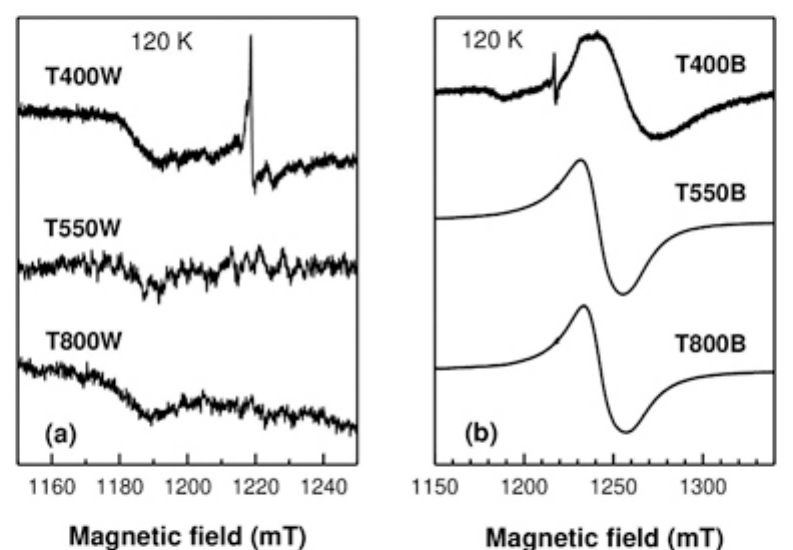
Figure 5. Q-band EPR spectra of the white ( a ) and black ( b ) samples at 120 K. The broad line at ~1185 mT in ( a ) is a background resonator signal.